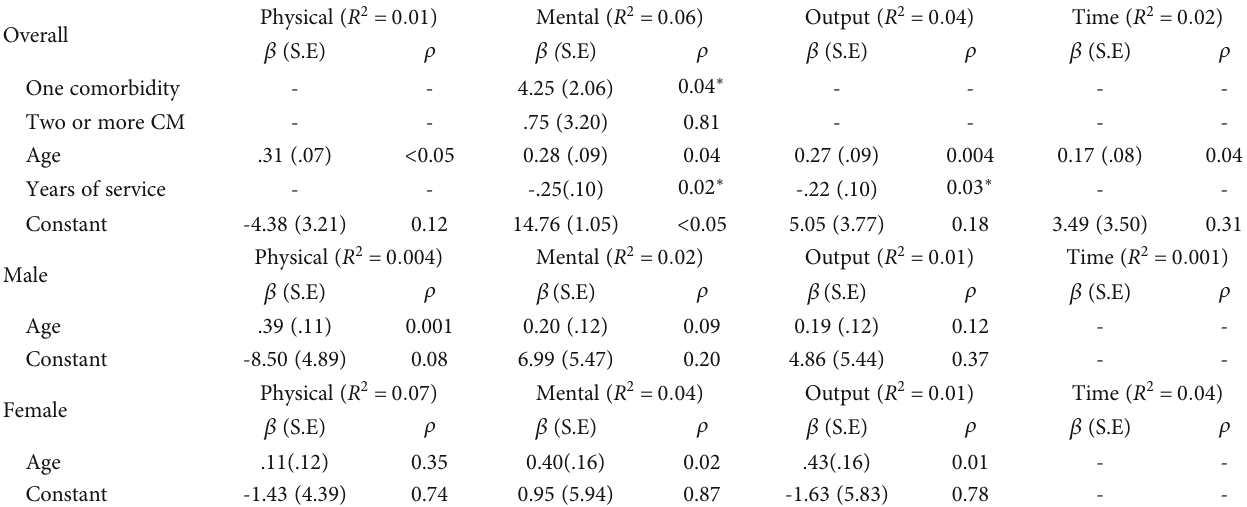
Table 7: Multivariate regression results for the work limitation subscales among fi re fi